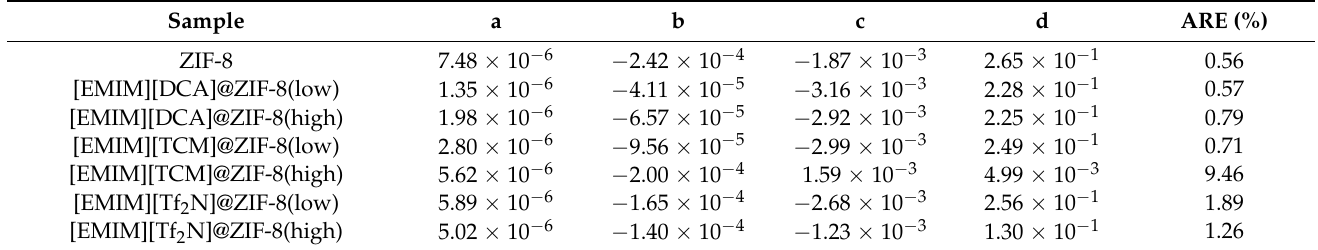
Table A2. CO 2 coefficient parameters and global average relative error of the fitting using Equation (3).